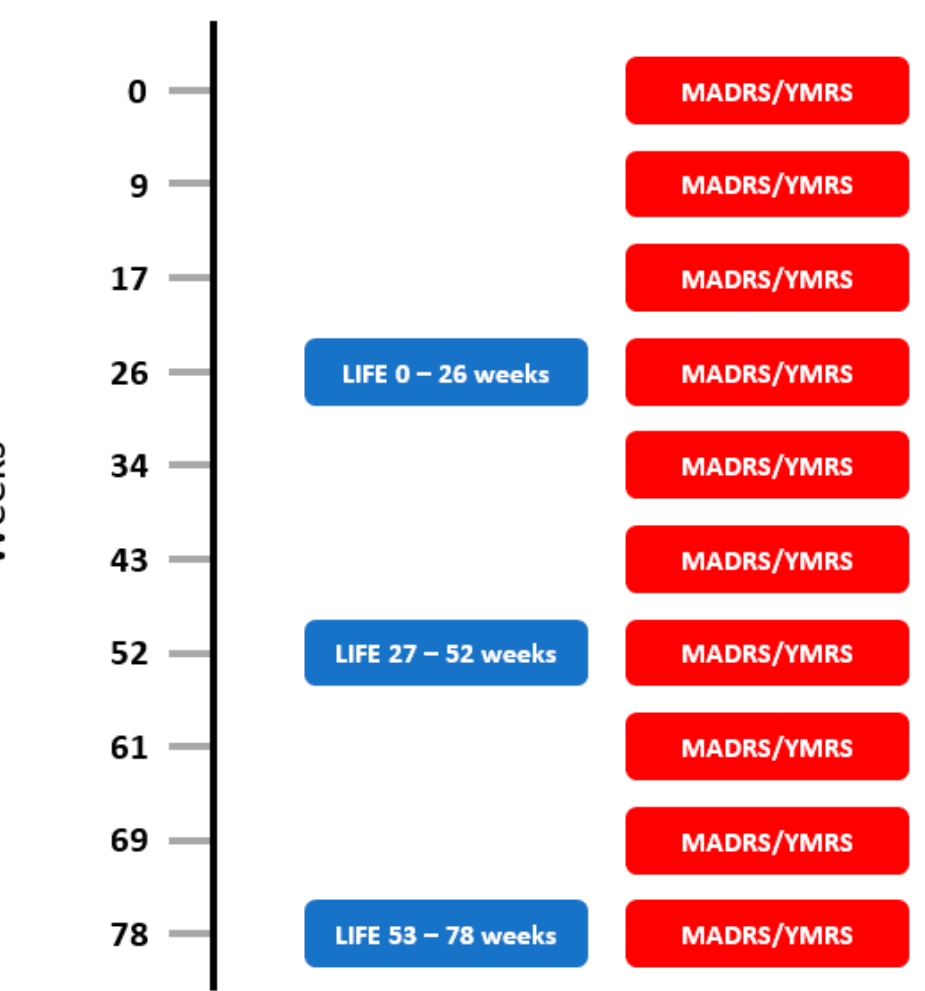
Figure 1. Timing of Longitudinal Interval Follow-up Evaluation (LIFE) and mood ratings using the Montgomery-Asberg Depression Rating Scale (MADRS) and the Young Mania Rating Scale (YMRS).